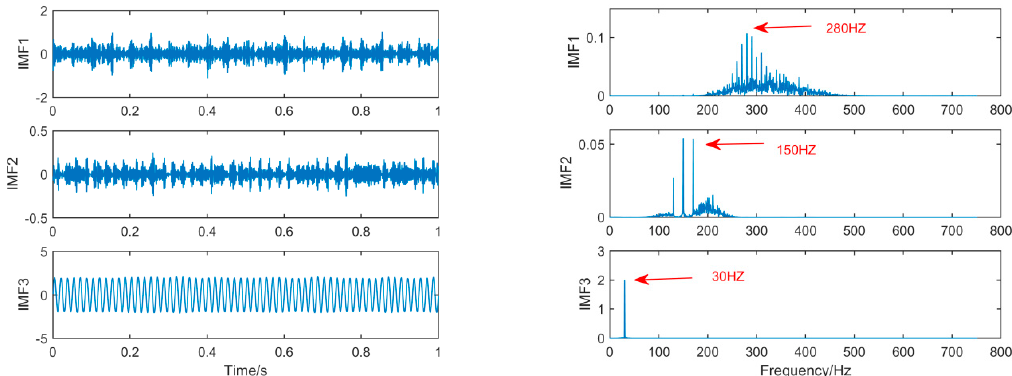
Figure 11. The spectrum of IMFs after MSSD and its corresponding spectrum after increase the noise amplitude.